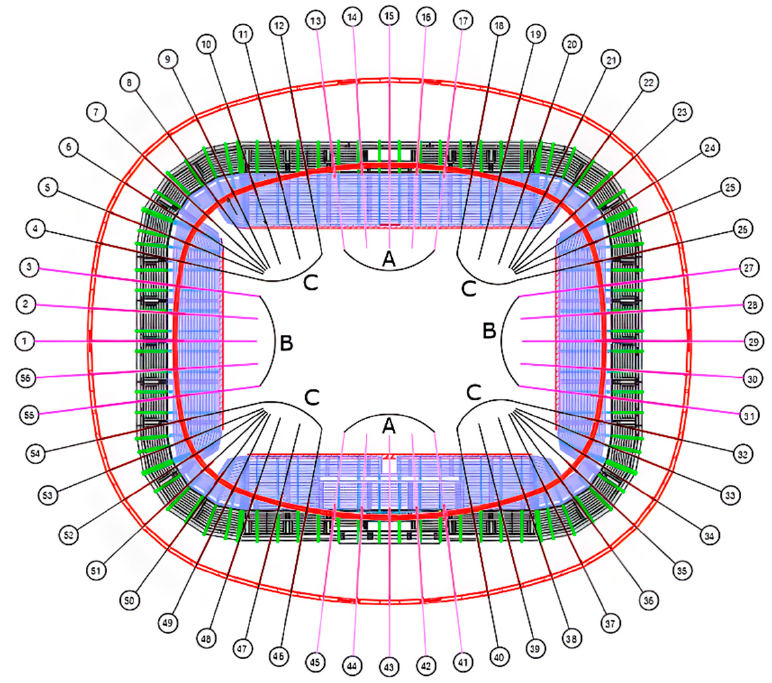
Figure 39. Division of tie-downs. (1~56 represent the NO. of radial cables corresponding to Axis NO.)